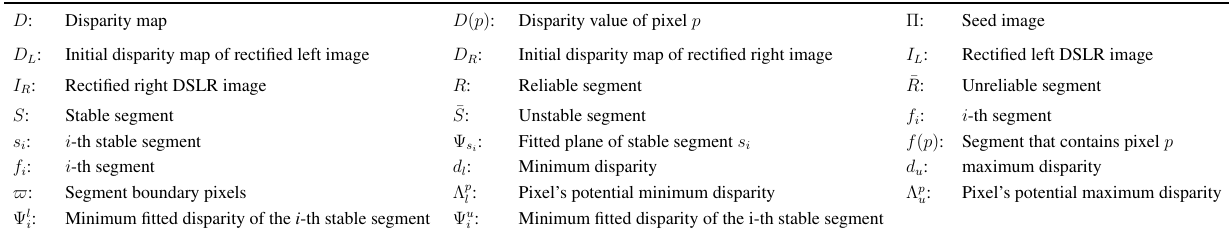
Figure 4. Conceptual flow diagram for the classification phase. Table 1.